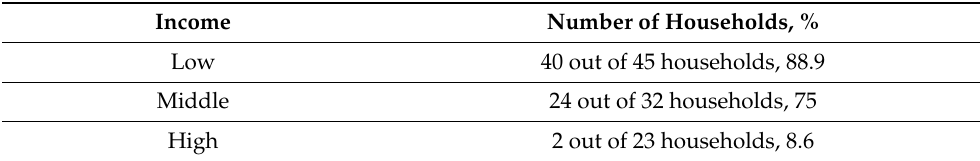
Table 2. The number of households whose water expenditure exceeds their ATP.